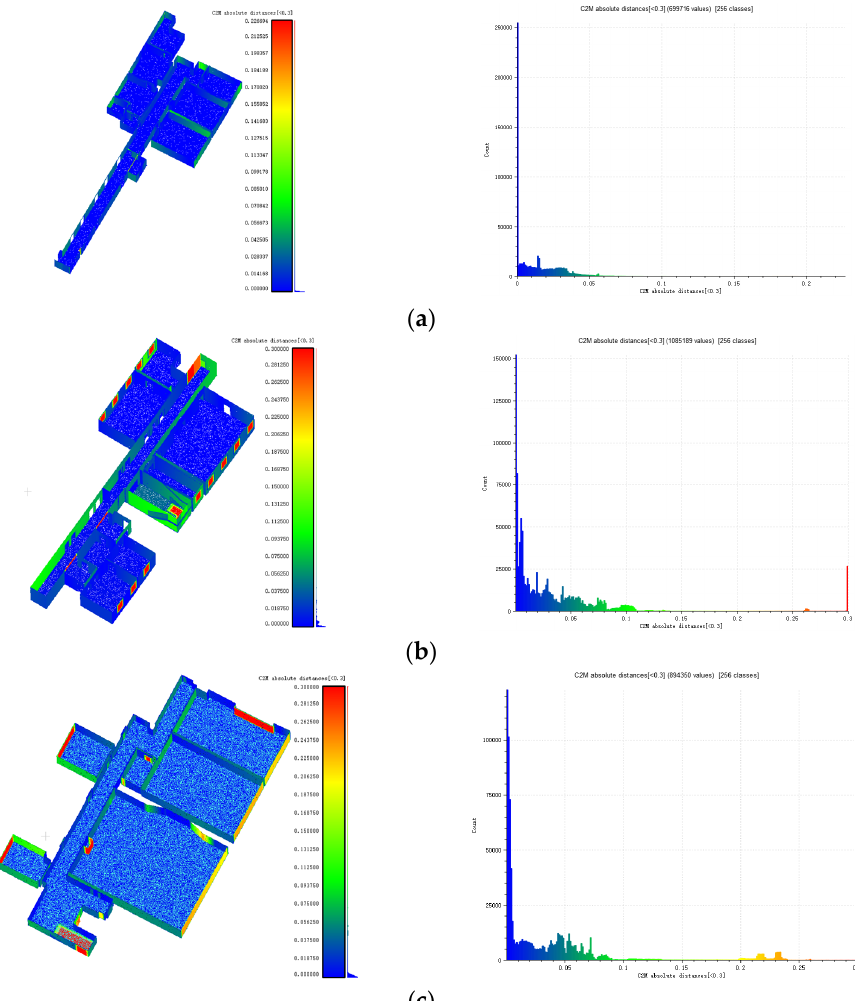
Figure 15. Visualization of unsigned distance deviations on the left and histogram of deviation statistics for the data on the right. ( a ) represents the accuracy evaluation results of TUB1. ( b ) represents the accuracy evaluation results of TUB2. ( c ) represents the accuracy evaluation results of UOM.